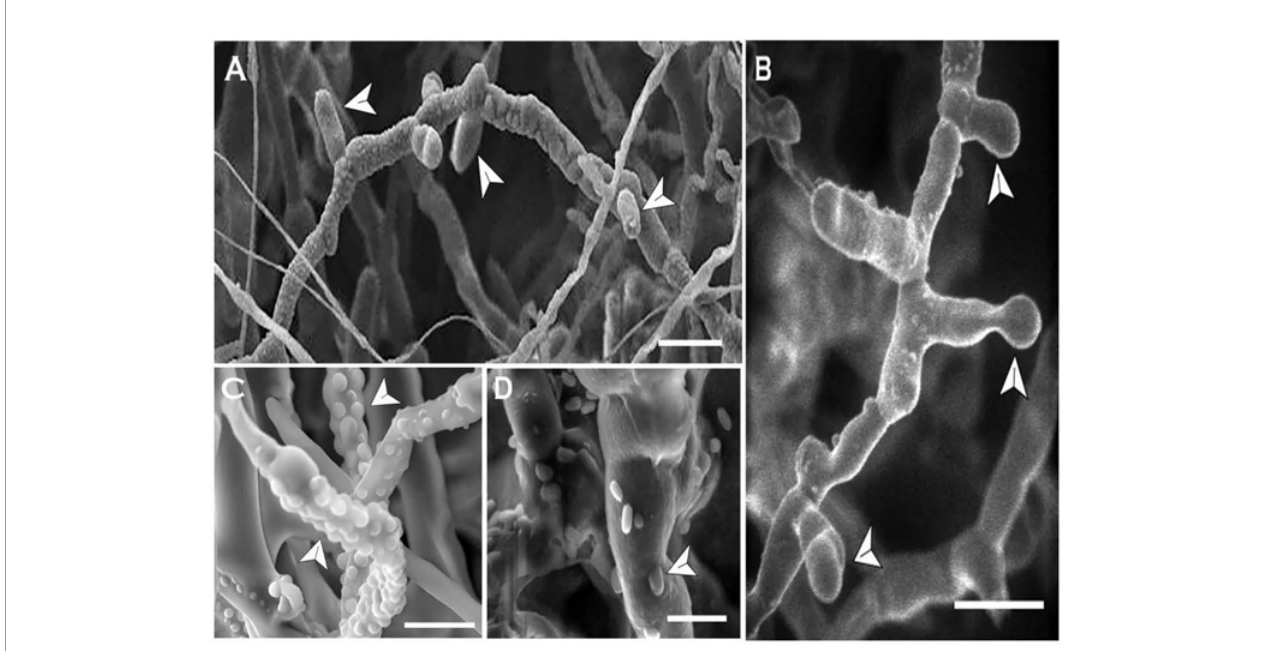
FIGURE 8 | In-vitro blastospore formation by Neopseudocercosporella capsellae hyphae as seen under the scanning electron microscope. Old septate hyphae producing meso-blastospores (arrows) at the septa (A) and the tip (B) at the transition stage (Scale bars =10µm). (C) Young hyphae showing buds for micro- blastospores (Scale bar = 5µm). (D) Old hyphae with micro-blastospore buds and single-celled micro-blastospores (arrows) separated from the original hyphae (Scale bar =